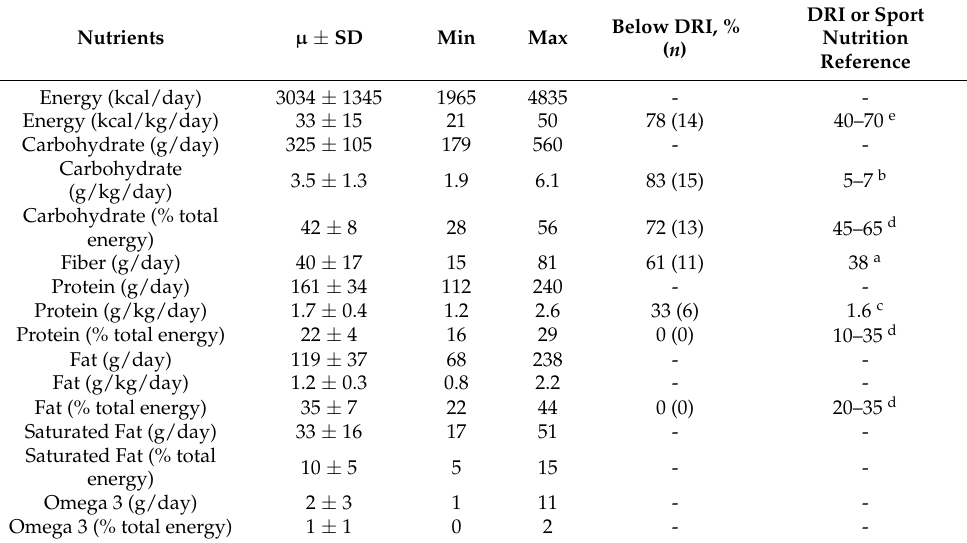
Table 2. Energy and macronutrient intake as well as proportion of players at risk of not meeting dietary intake guidelines ( n = 18).